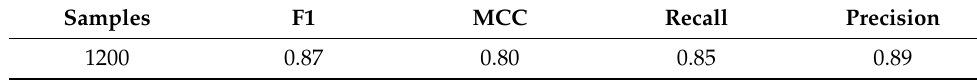
Table 1. Defect detection of solders for A0.